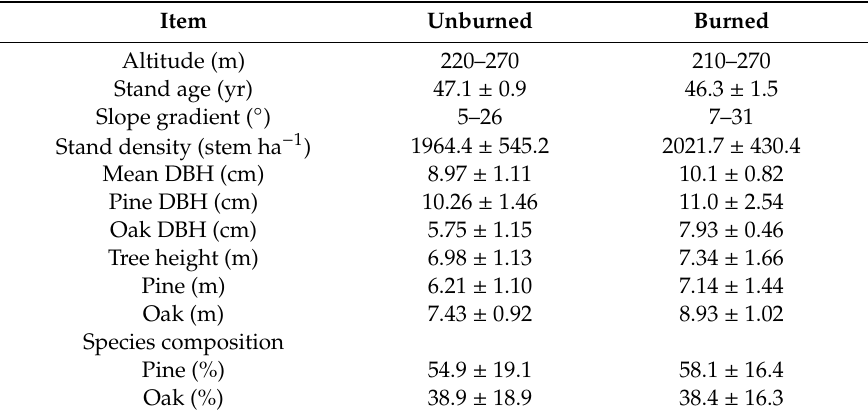
Table 1. General description of the unburned and burned plots in the coniferous–broadleaf